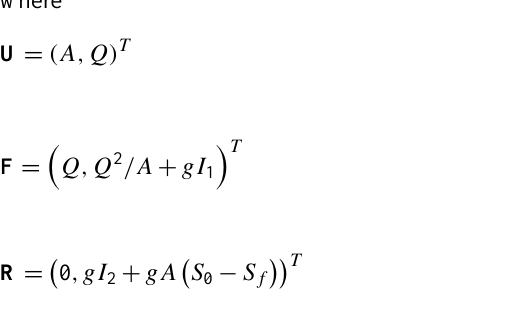
Figure 3. Example of pipe junction.